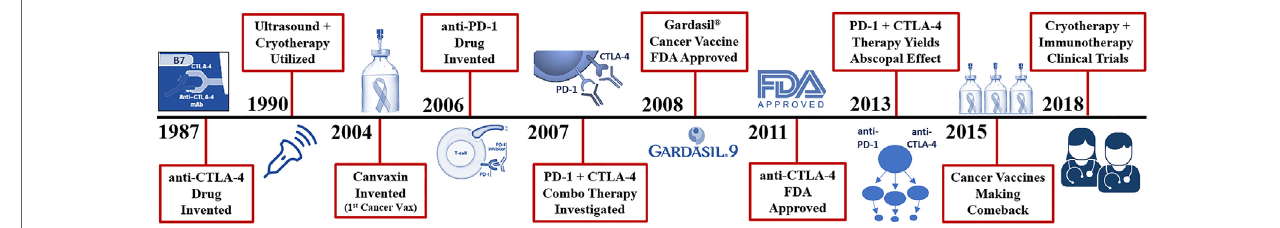
FiGURe 3 | Recent history of cryosurgery and immunotherapy R&D. Vaccines are the only mechanism in which entire species of genome have been eradicated from the human population (smallpox, chickenpox, measles virus). Presently, cancer vaccines like Gardasil 9 ® can reduce the number of cervical, and likely oral cancers observed through the protection from 9 types of inciting human papilloma viruses. True cancer vaccines, such as Canvaxin ™ (2004), have been produced and investigated but most have yielded underwhelming results in creating an effective highly targeted tumor antigen which would likely kill a pure monoclonal or homogenous tumor yet fails in a heterogenous population of cancer cells. Many of the highly specific vaccines developed for melanoma, glioblastomas, and colon cancer have been ineffective or weakly effective; however, now when combined with cytotoxic T-lymphocyte-associated protein (CTLA-4) and PD-1 checkpoint inhibitors, are becoming more effective and garnering more clinical investigation. The addition of checkpoint inhibitors to potentiate these more advanced cancer vaccines does appear to yield impressive outcomes but still with lower than desired